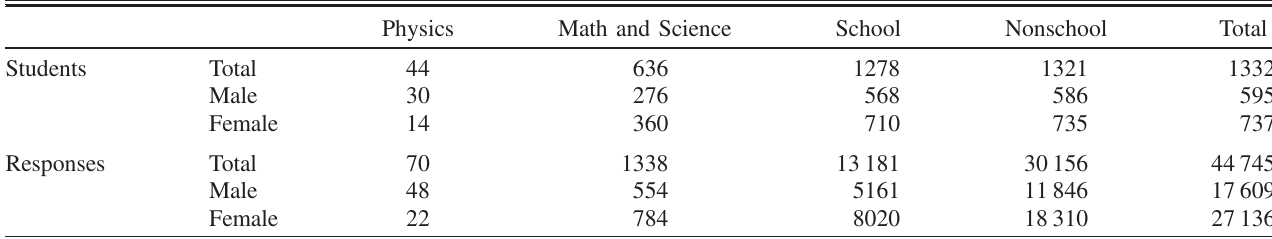
TABLE I. Structure of the SSYSD ESM